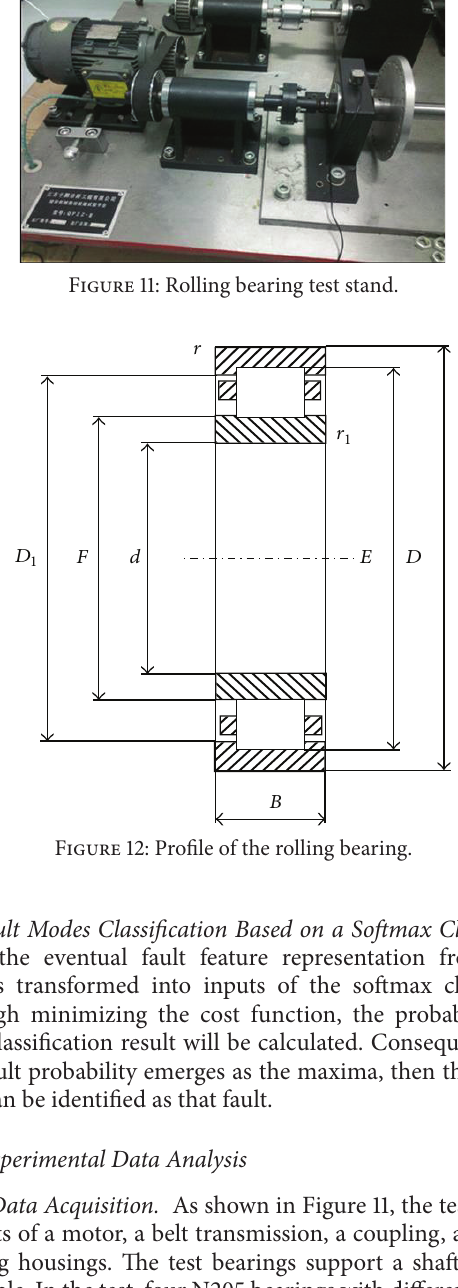
Table 1: Rolling bearing parameters.